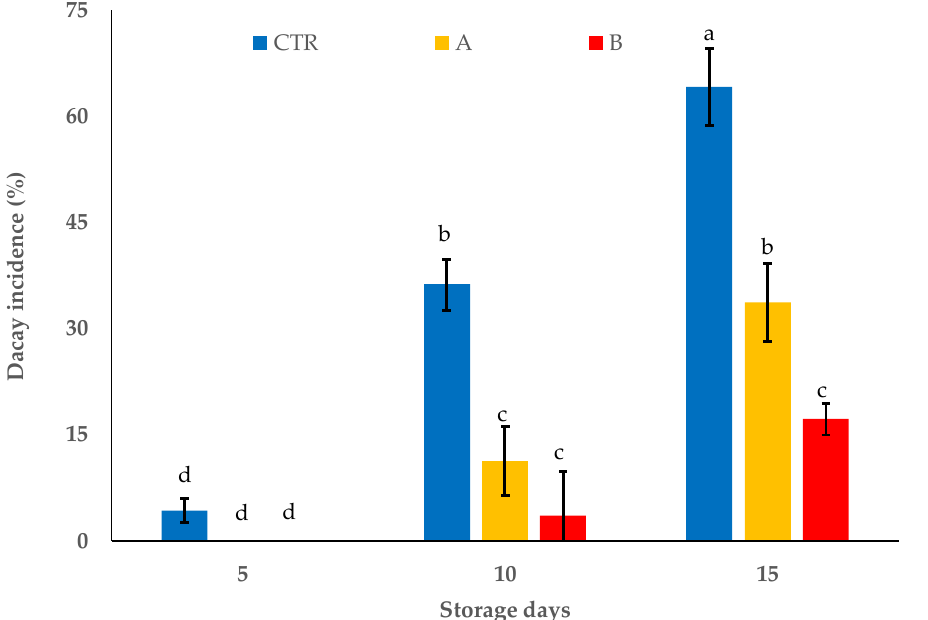
Figure 2. R . oryzae ITEM 18876 decay incidence percentages on the inoculated table grapes (cv. Italia) packed in HDPE bags with different citral doses (A equal to MIC value of 0.0125 µ L/cm 3 and B equal to 4-fold MIC value of 0.05 µ L/cm 3 , respectively) and stored at 12 ◦ C and 85% relative humidity for 15 days. CTR: control without citral. Bars are means ± standard deviations ( n = 3). Bars with different lowercase letters represent significantly different averages ( p < 0.0001; HSD Tukey’s test; F (8.18) = 89.297, p = 6.732 × 10 − 13 ).